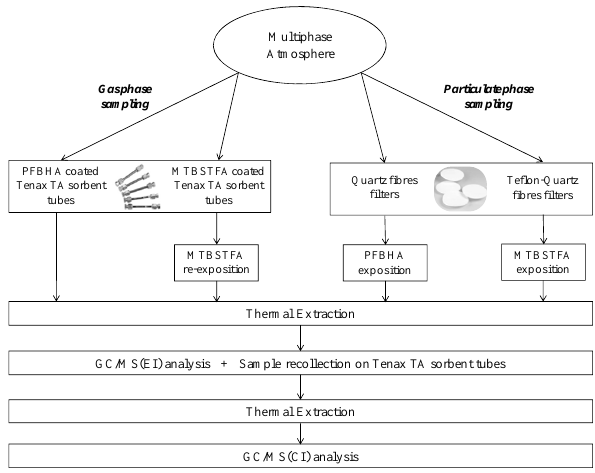
2 Fig. 3. Method overview Fig. 3. Method